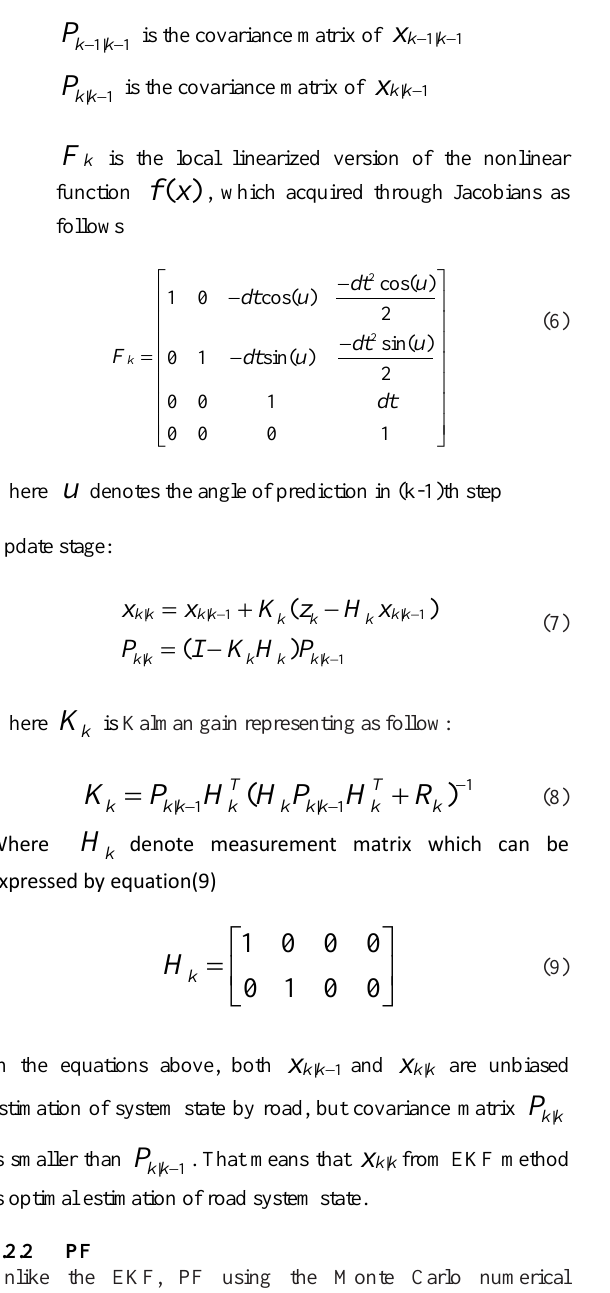
Figure 2. The flow of road